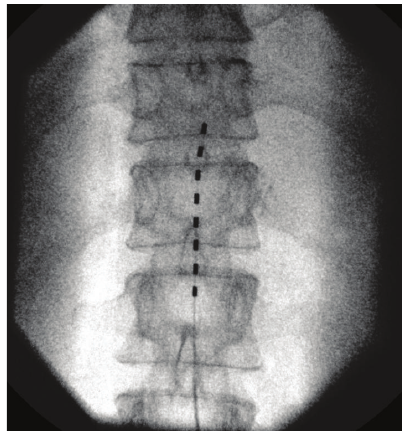
Figure 3: AP fluoroscopic view of SCS implantation.